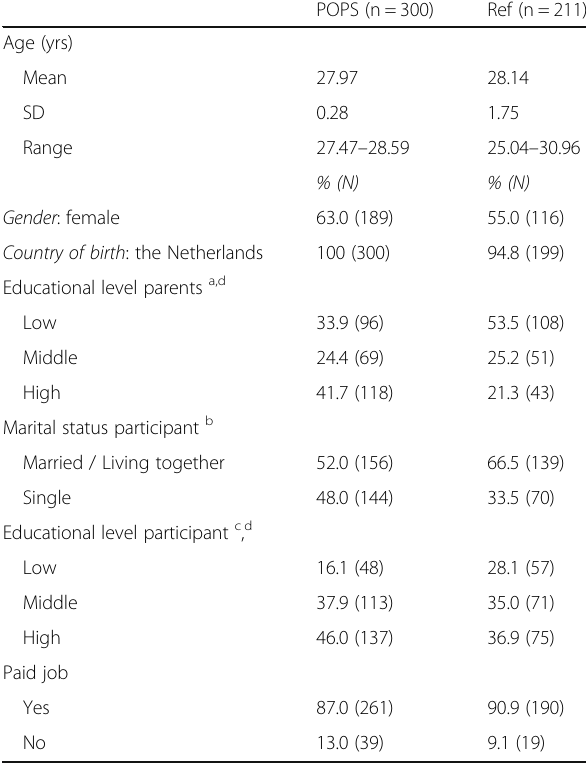
Table 2 Socio-demographic